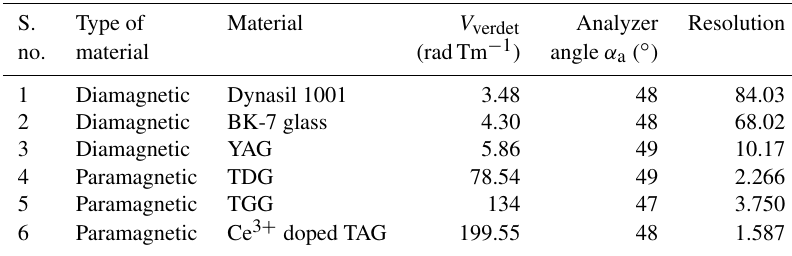
Table 4. Maximum sensitivity achieved at 1064nm wavelength for magnetic field range 0–10mT (corresponding to Fig. 4). S. Type of Material V verdet Analyzer % increase in Resolution no. material (radTm − 1 ) angle α a ( ◦ ) sensitivity 1 Paramagnetic TGG 40 42 Datum level 2 Paramagnetic Nd 3 + doped TGG 3 Paramagnetic Ce 3 + doped TGG Paramagnetic 5 Paramagnetic Pr 3 + doped TGG